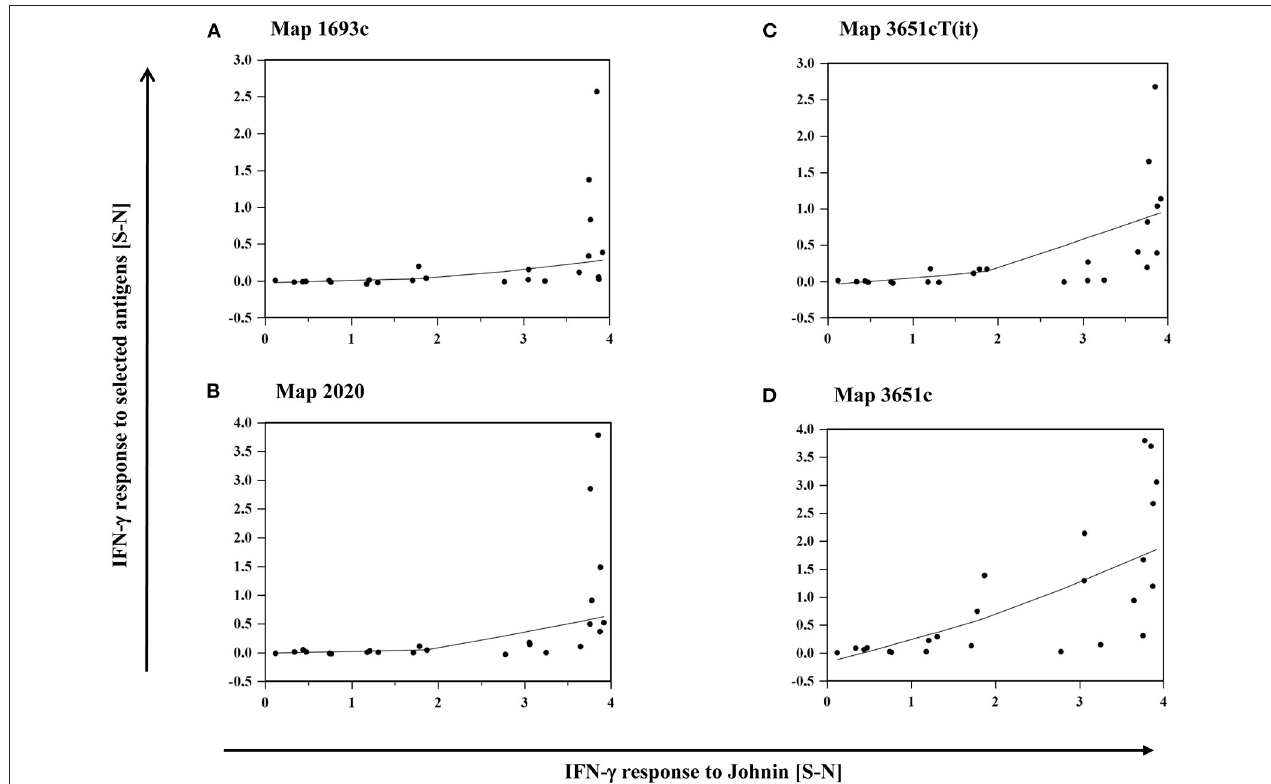
FIGURE 6 | (A–D) : Relation between the IFN- γ response of MAP inoculated goats to PPDj and selected MAP antigens, (A) Map 1693, (B) Map 2020, (C) Map 3651cT(it), and (D) Map 3651c. Data of three time points (19–22, 27–30, and 45–48 wpi) are summarized. Each dot represents one animal. Line: local regression smoothing trend line with smoothing span of